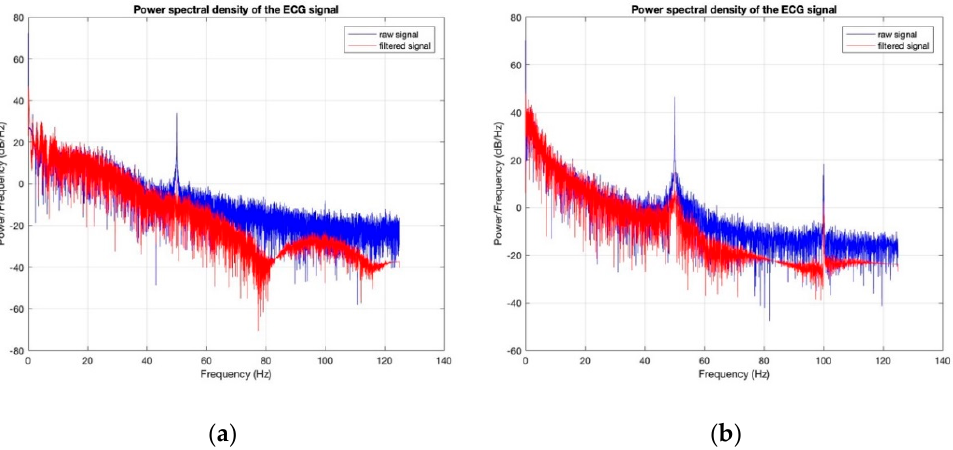
Figure 22. Power Spectral Density of ECG signal obtained by cotton/Lycra electrodes with 6.3 wt.%